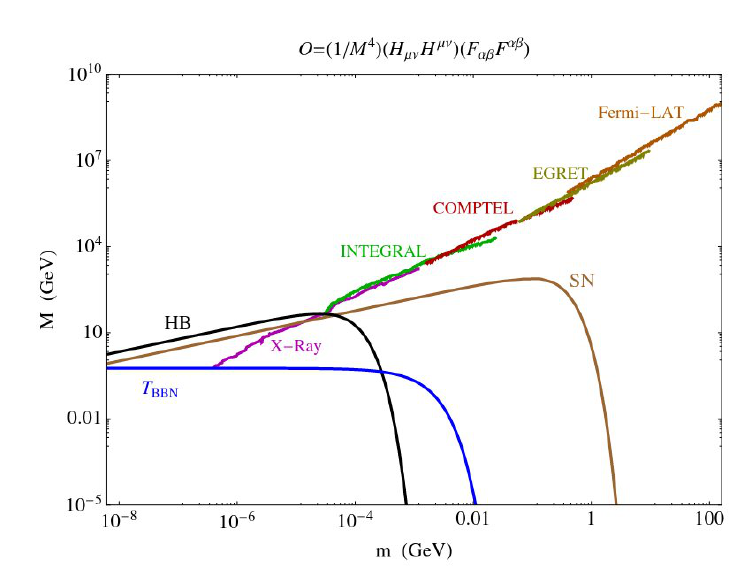
Figure 12: Constraints on the scale M for the M − 4 B 2 tr G 2 portal versus glueball mass, from cosmic ray mononergetic line searches and energy loss in horizontal branch stars or type II supernovae [ 74 ]